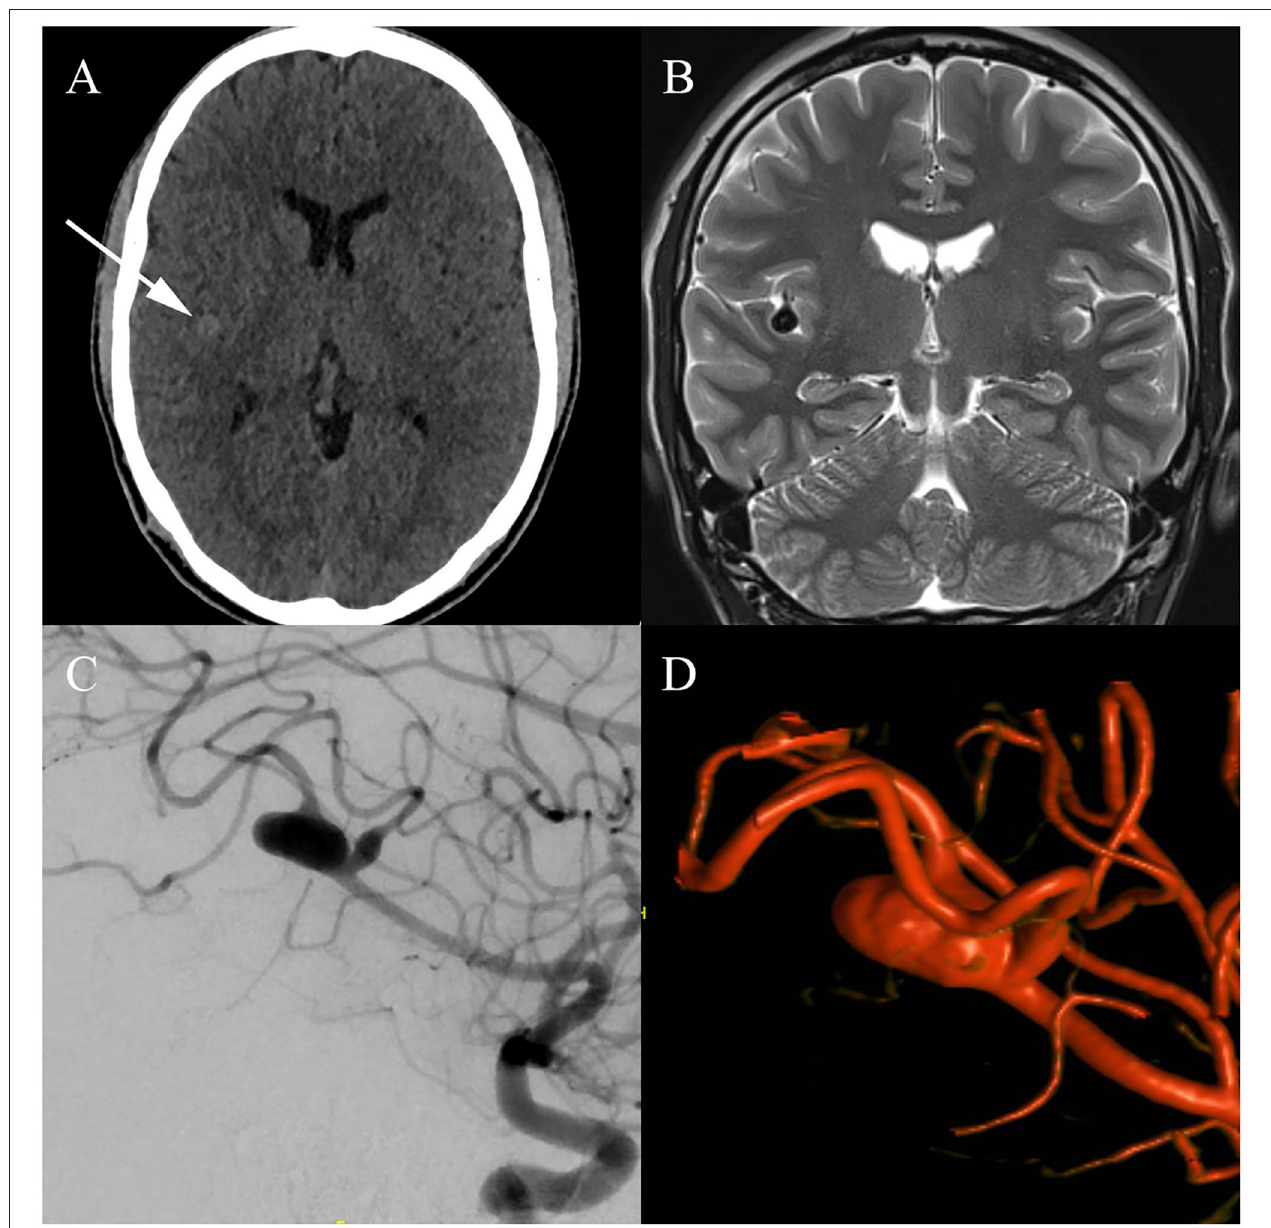
FIGURE 1 | Initial imaging findings: (A) Initial computed tomography (CT) images reveal a hyperdense structure confined to the right Sylvian fissure, leading to further investigation with magnetic resonance imaging (MRI). (B) T2-weighted MRI images do not confirm the suspected hemorrhage; instead, a fusiform aneurysm located in the distal M2-segment of the right middle cerebral artery (MCA) is delineated. (C) Cerebral angiogram illustrates a fusiform aneurysm, located in the inferior trunk of the right MCA. Furthermore, fusiform dilatation of a parieto-occipital branch arising from the right MCA is seen. The lesions are located adjacent to the right insula, in the depth of the Sylvian fissure. (D) Three-dimensional volume-rendering technique (VRT) of the